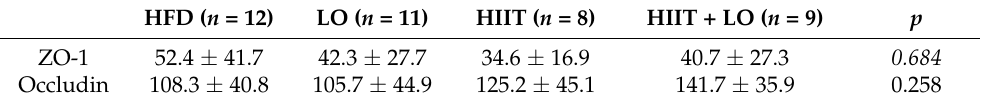
Table 2. Zonula occludens 1 (ZO-1) and occludin expression (a.u.) by western blotting of colon protein extracts in the four groups: HFD ( n = 12), LO ( n = 11), HIIT ( n = 8), and HIIT + LO ( n = 9).